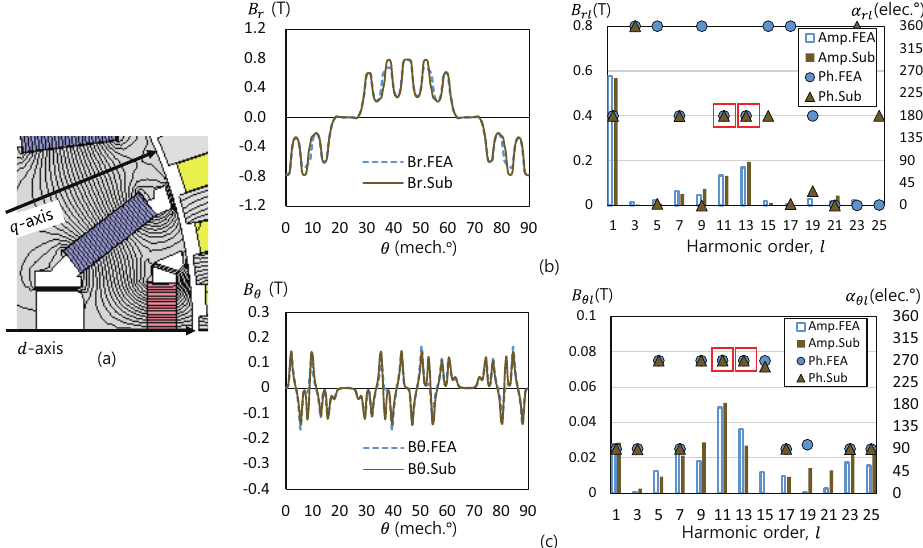
Figure 2. Comparisons of instantaneous air-gap fields when the cogging torque is zero: ( a ) flux lines, ( b ) radial fields, and ( c ) circumferential